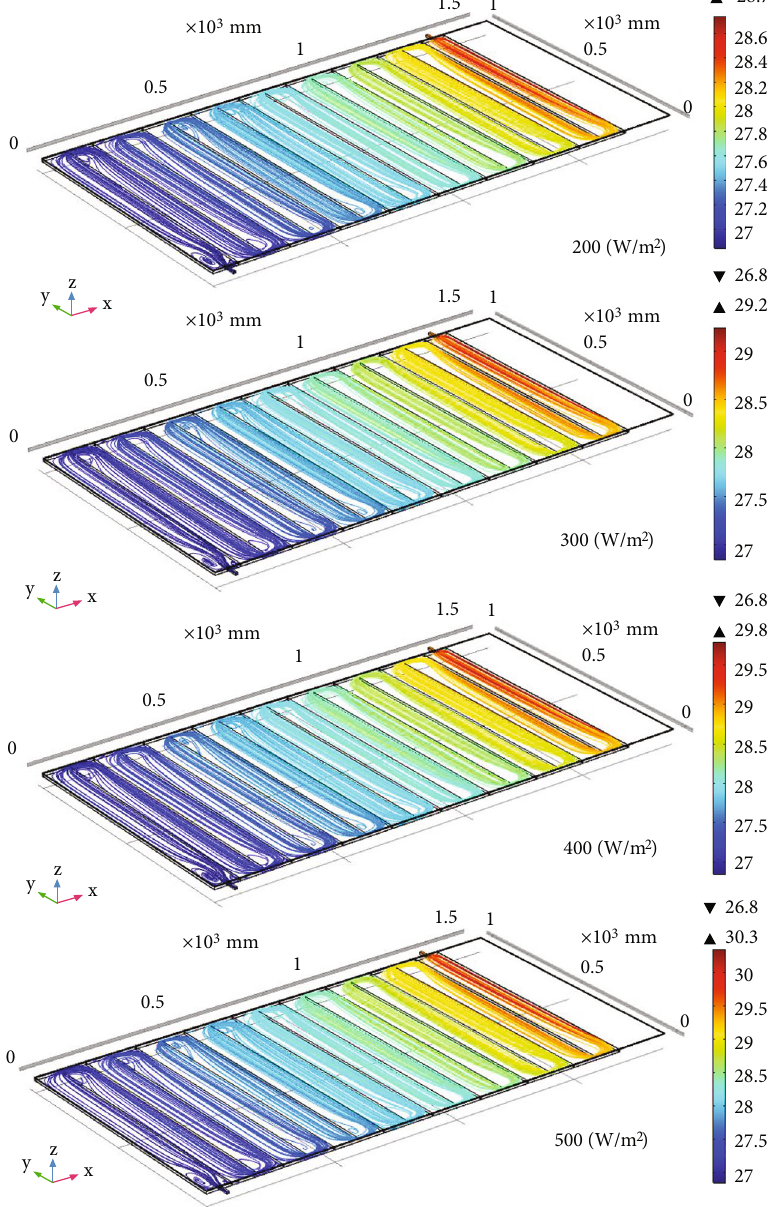
Figure 5: Outcome of irradiance on PVT streamlines plot with V